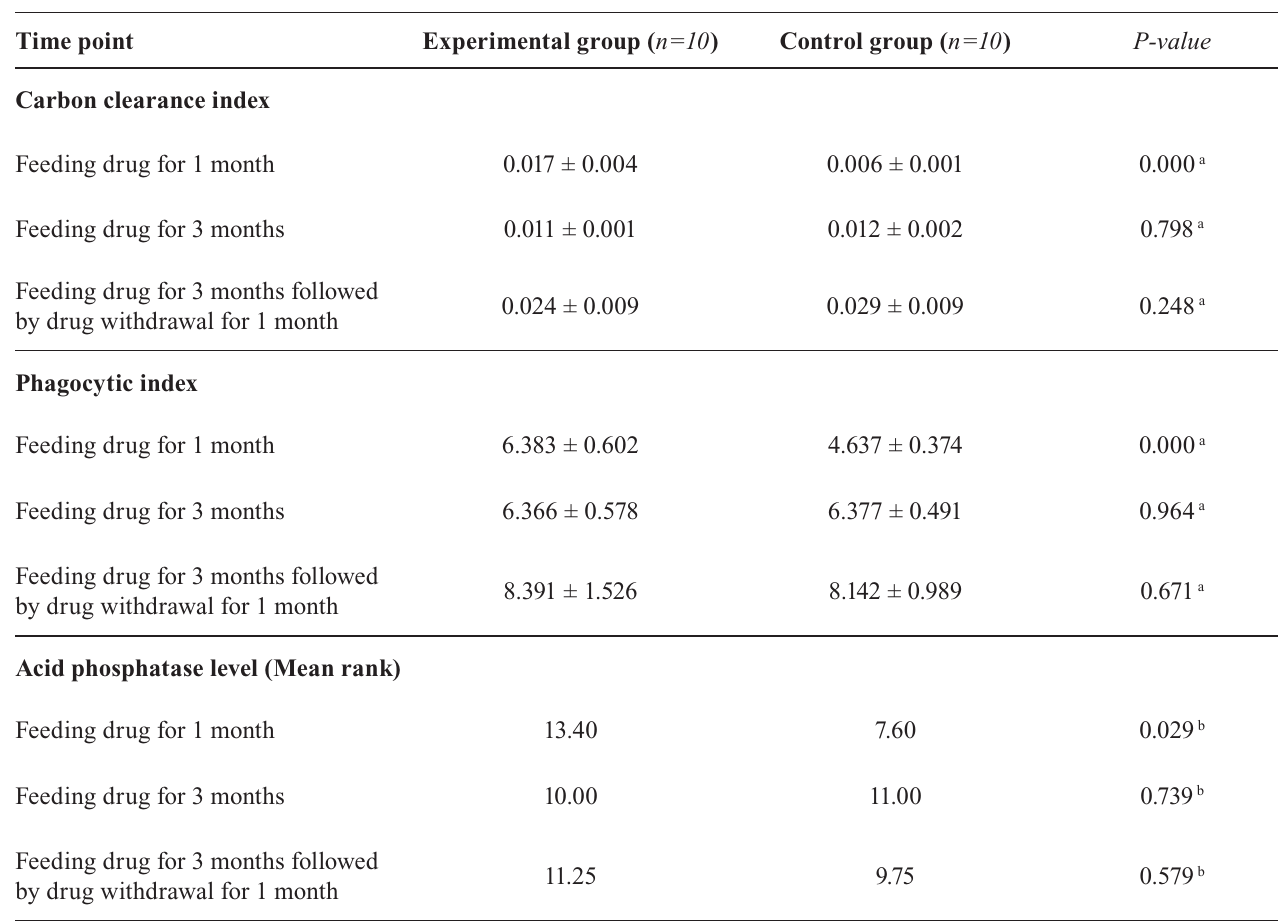
TABLE III - Comparison of carbon clearance, phagocytic index and acid phosphatase level in the experimental and control groups at the three time points